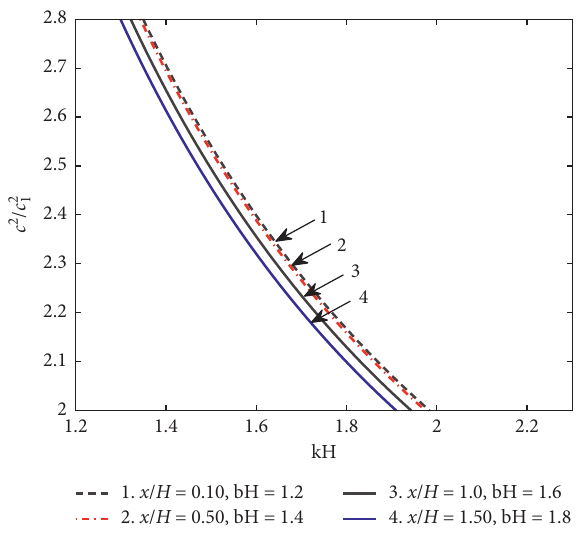
Figure 3: Medium of the Love wave